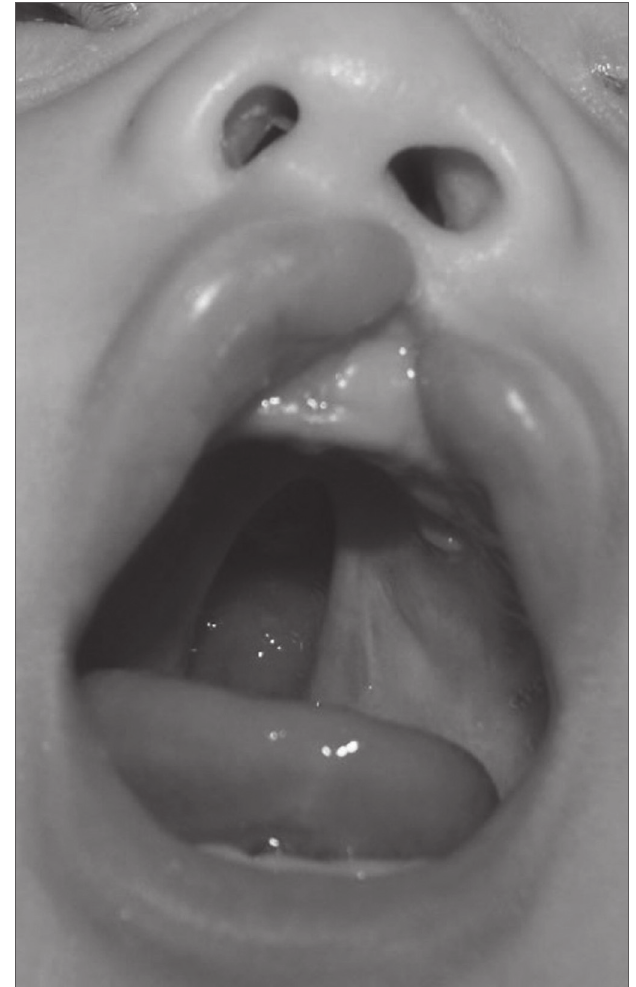
Figura 2. Paciente com fissura labial esquerda incompleta associada à fissura palatina